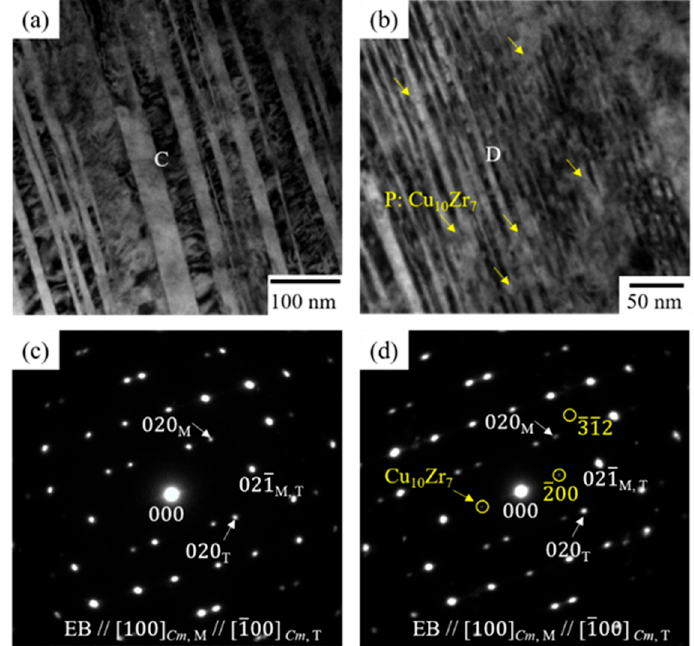
Figure 3. ( a , b ) Bright field images of 10th cycled equiatomic CuZr alloy, and ( c , d ) electron diffraction patterns taken from the boundary between martensitic variants in ( a ) and ( b ).